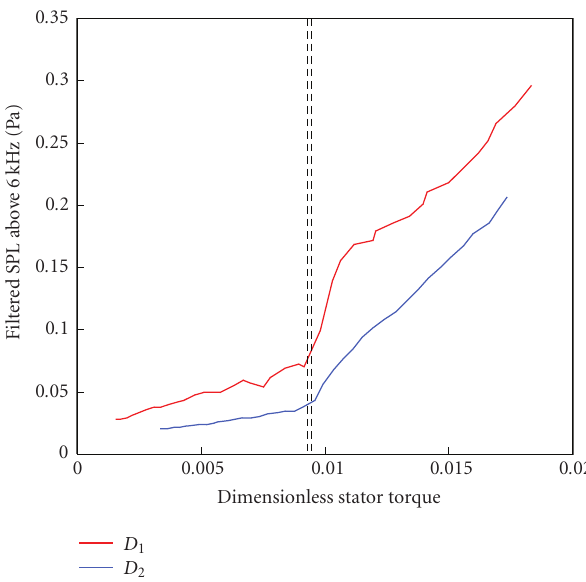
Figure 7: Filtered SPL versus dimensionless stator torque for stall speed sweep of 40RPM/s at p c = 791kPa, p b = 584 kPa, and θ in = 70 ◦ C. Vertical dashed lines indicate onset of